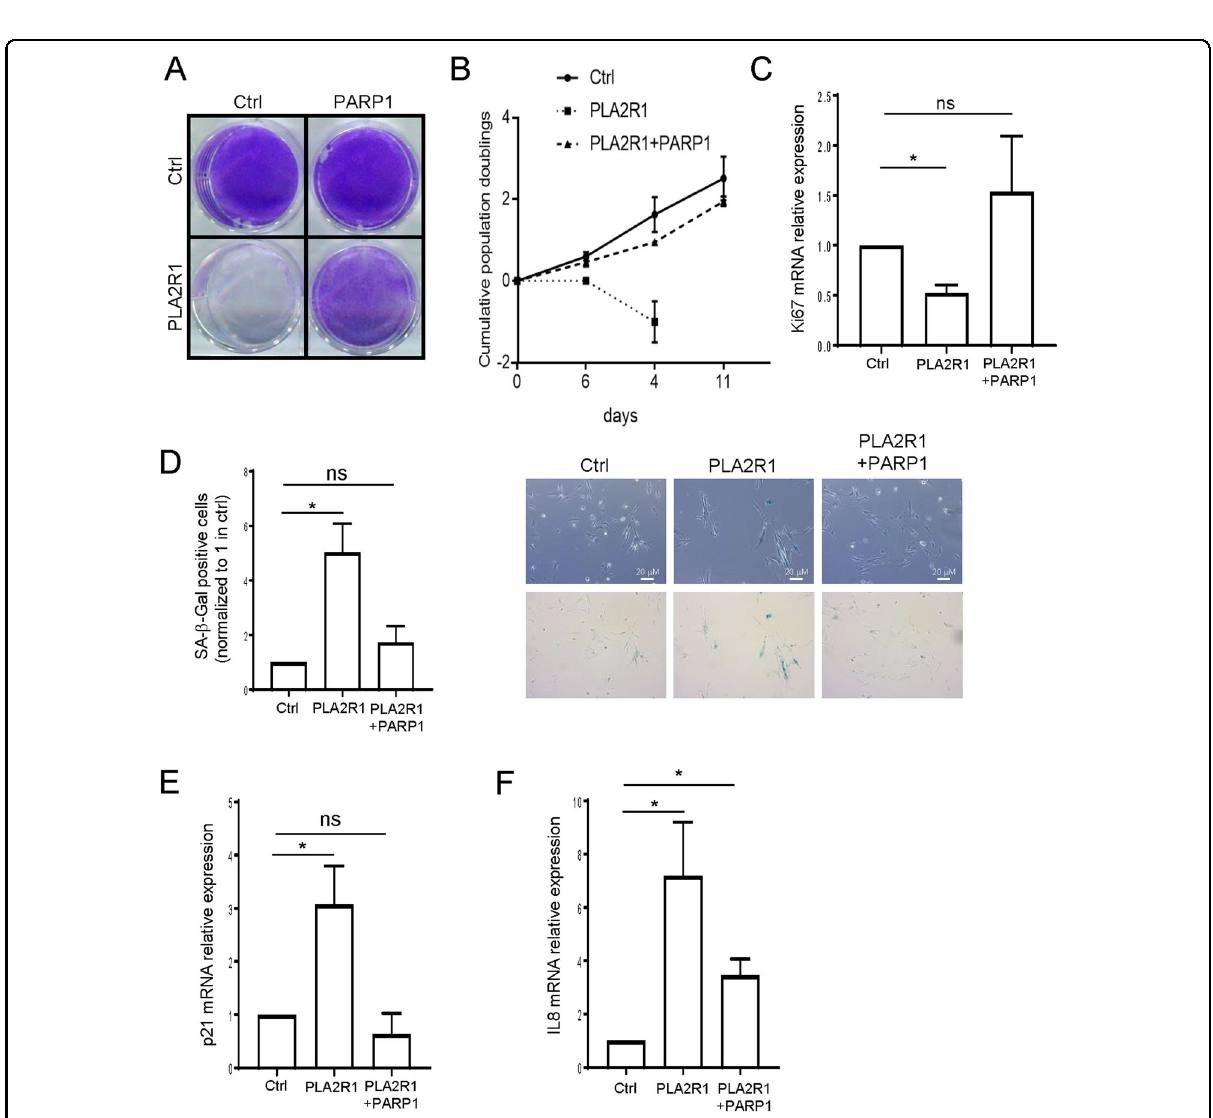
Fig. 4 PARP1 expression inhibits senescence induced by PLA2R1. E – F MRC5 cells were infected with control, PLA2R1-, or PARP1-encoding retroviral vectors as indicated, and selected. A Fourteen days after seeding, cells were fi xed and stained by crystal violet to visualize cell density. B The growth curve was performed by counting the number of cells and calculating the population doublings at each cell passage. Representative growth curves from three experiments with SD are shown. C RNA was prepared and RTqPCR performed against the proliferation marker Ki67 and normalized against GAPDH levels ( n = 3). D Cells were fi xed and a SA ‐ β ‐ galactosidase assay was performed. Percentage of SA- β -Gal positive cells was calculated and representative images are shown ( n = 3). E , F RTqPCR performed against p21 ( E ) and IL8 ( F ) and normalized against GAPDH levels ( n = 3). Graphs C – F show mean between three experiments± SEM and p value was calculated using Student ’ s t -test. * p <